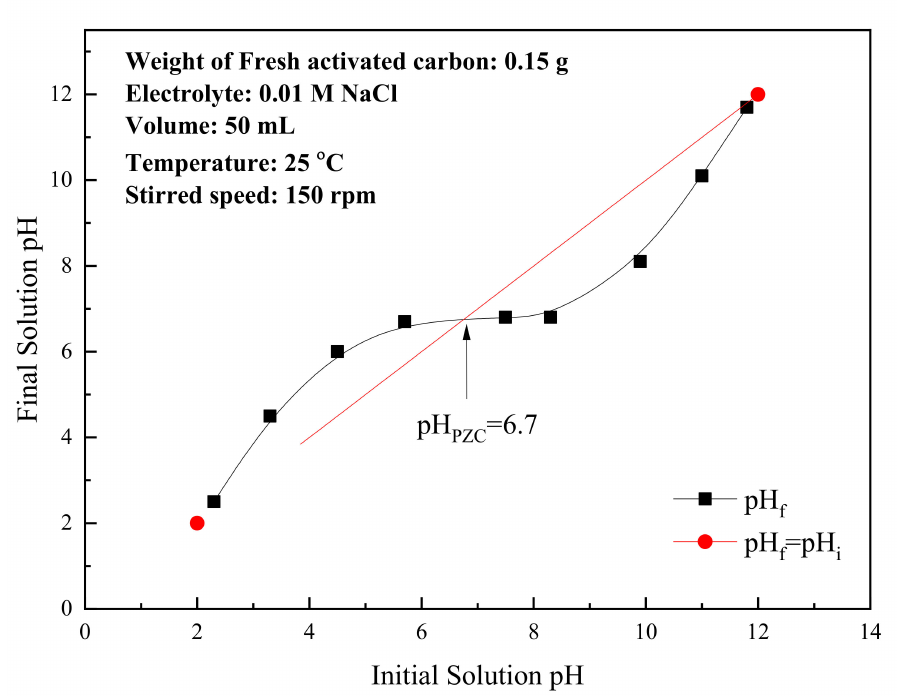
Figure 3. Point of zero charge titration for fresh activated